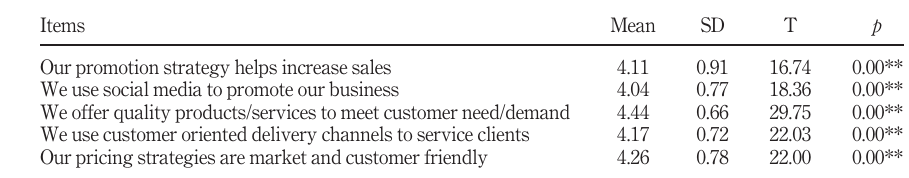
Table VI. Marketing mix